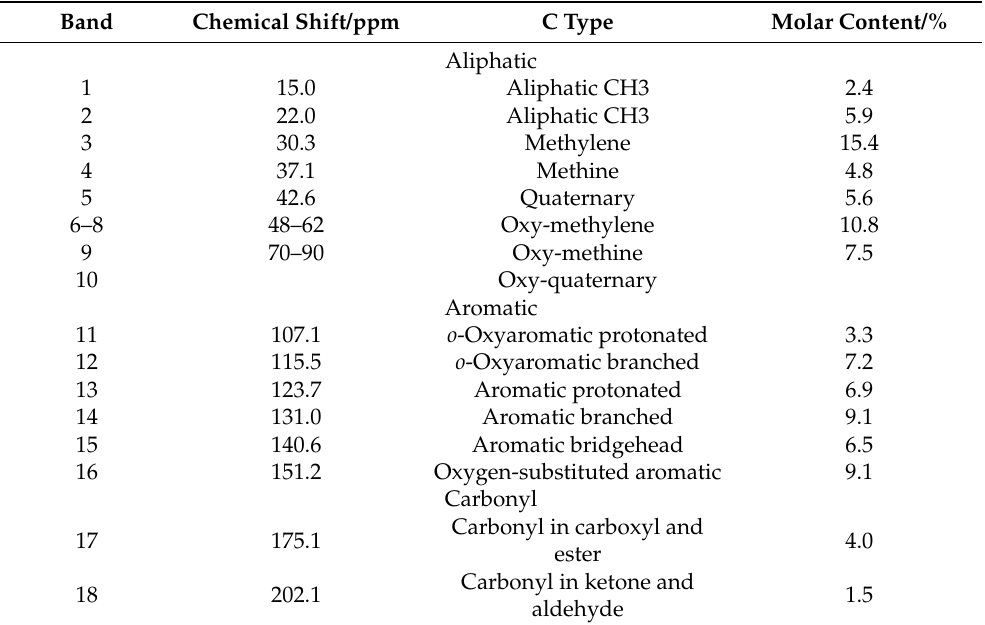
Figure 6. The 13 C NMR spectra of lignite coal [68]. Table 5. Chemical shifts and molar contents of C types in lignite coal were analyzed by 13 C NMR [68].